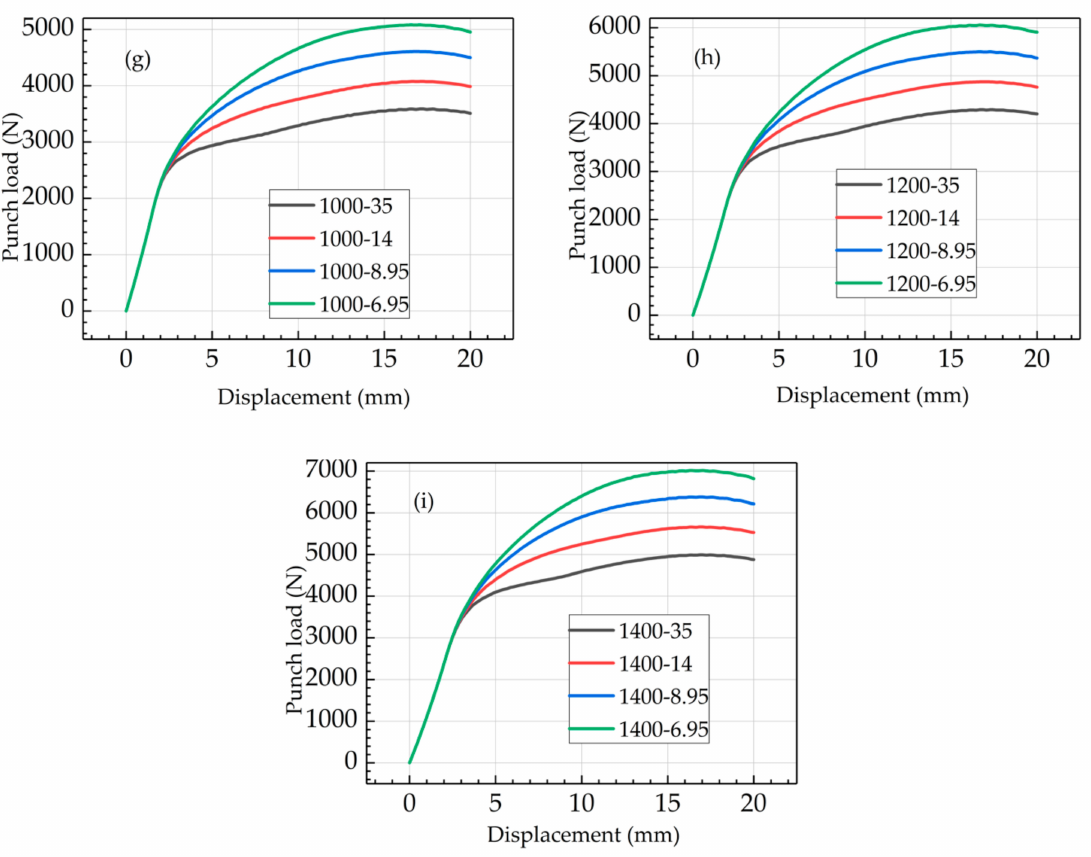
Figure 10. Bending force stroke curve of hypothetical materials: ( a ) 100MPa; ( b ) 250MPa ( c ) 400MPa; ( d ) 550MPa; ( e ) 700MPa; ( f ) 850MPa; ( g ) 1000MPa; ( h ) 1200MPa; ( i )